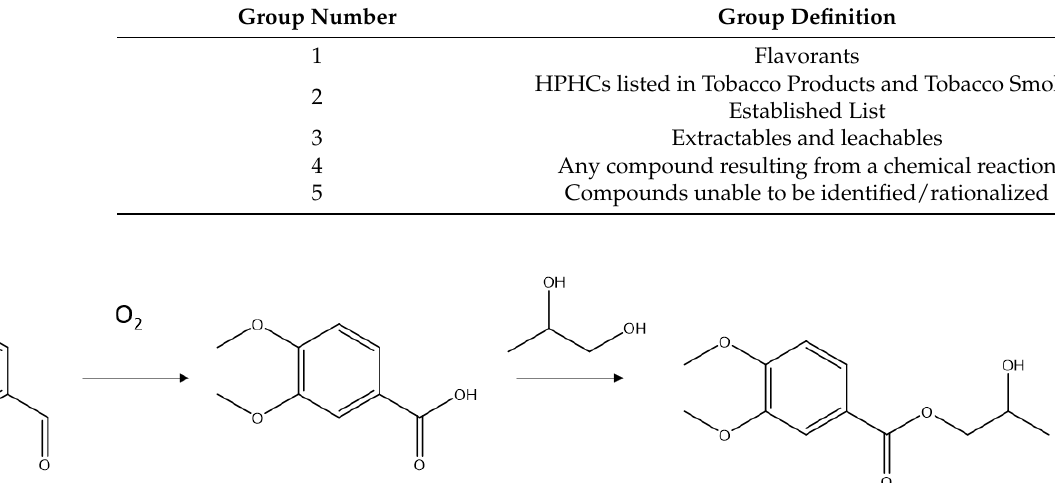
Figure 2. Examples of Possible Chemical Pathways Used for Rationalizing a Reaction Product.